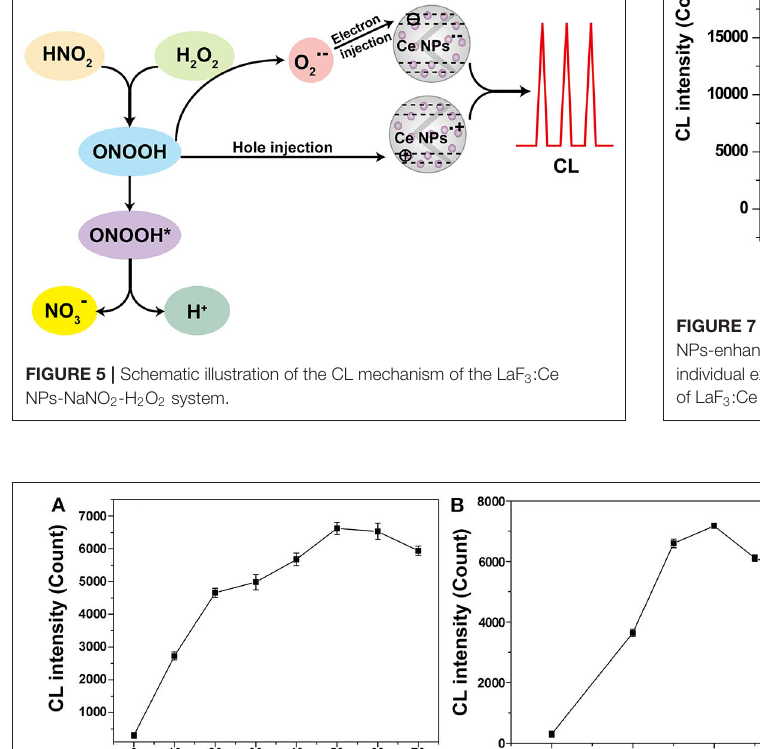
Frontiers in Chemistry |